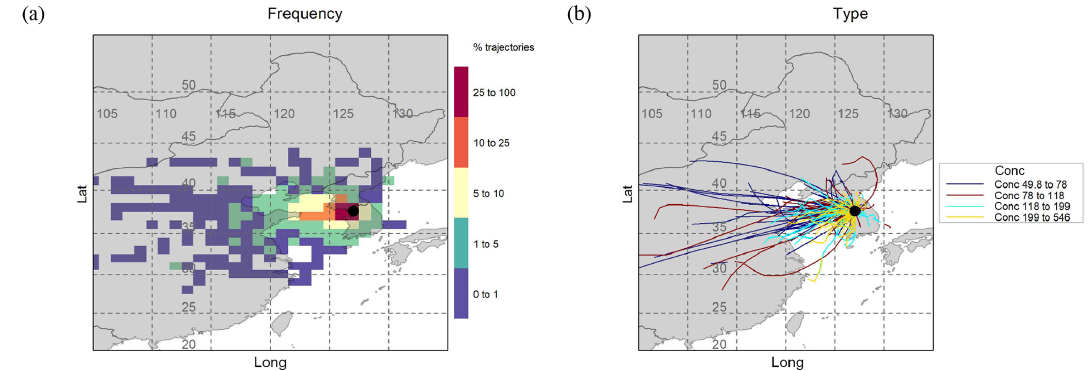
Figure 11. (a) Plot of the frequency of trajectories and (b) the trajectories, classified by their concentration values.